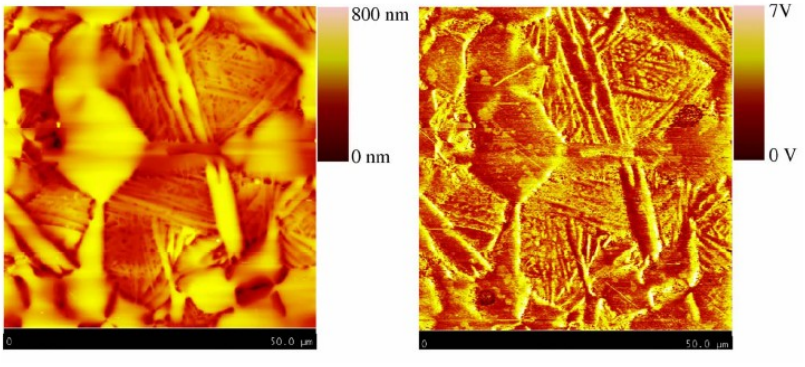
Figure 17. Topography and eddy current image obtained on Titanium